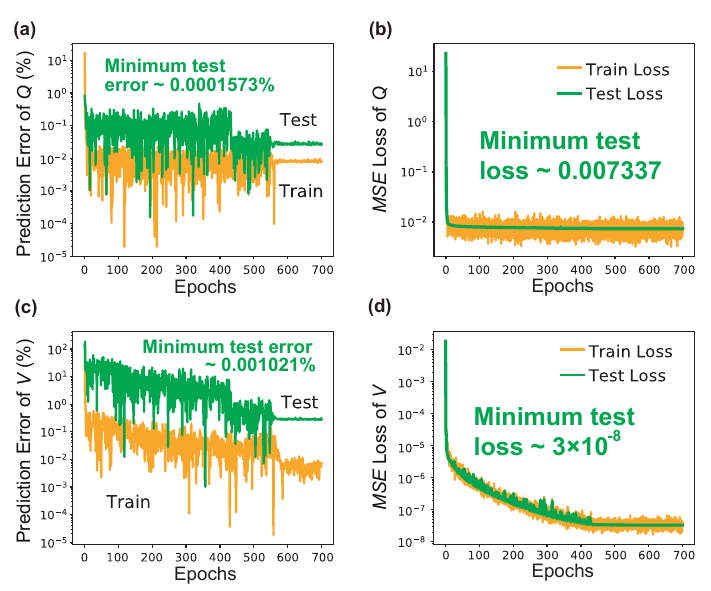
Figure 6. Learning curves of LRS-RCNN when trained to characterize nanobeam’s Q and V . Top panel contains results for Q : ( a ) prediction error (cid:101) pred vs. Epochs curve; ( b ) MSE vs. Epochs curve, for both training (yellow) and test (green) datasets. Min (cid:101) pred and MSE using the test dataset are also labeled on the figures, respectively. Bottom panel are the same results for V ( c , d